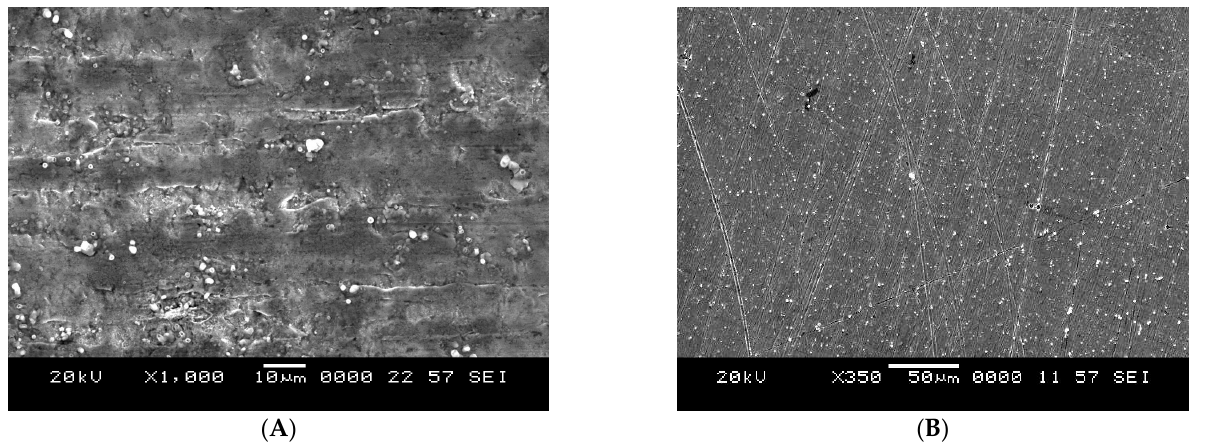
Figure 14. SEM micrographs of soft ‐ cast steel surface in ( A ) 1 mol dm − 3 HCl ( B ) 50 ppm concentration of olmesartan in 1 mol dm − 3 HCl.